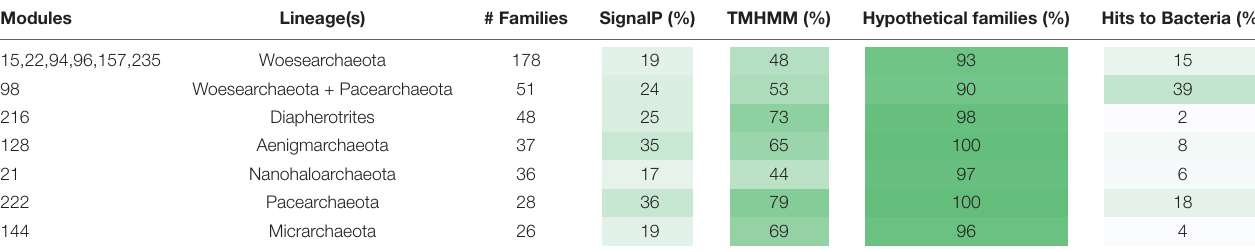
TABLE 1 | List of the eleven modules that are assigned to a single DPANN lineage and the module 98 that is taxonomically assigned to both the Woesearchaeota and the Pacearchaeota within the genomes of DPANN archaea.